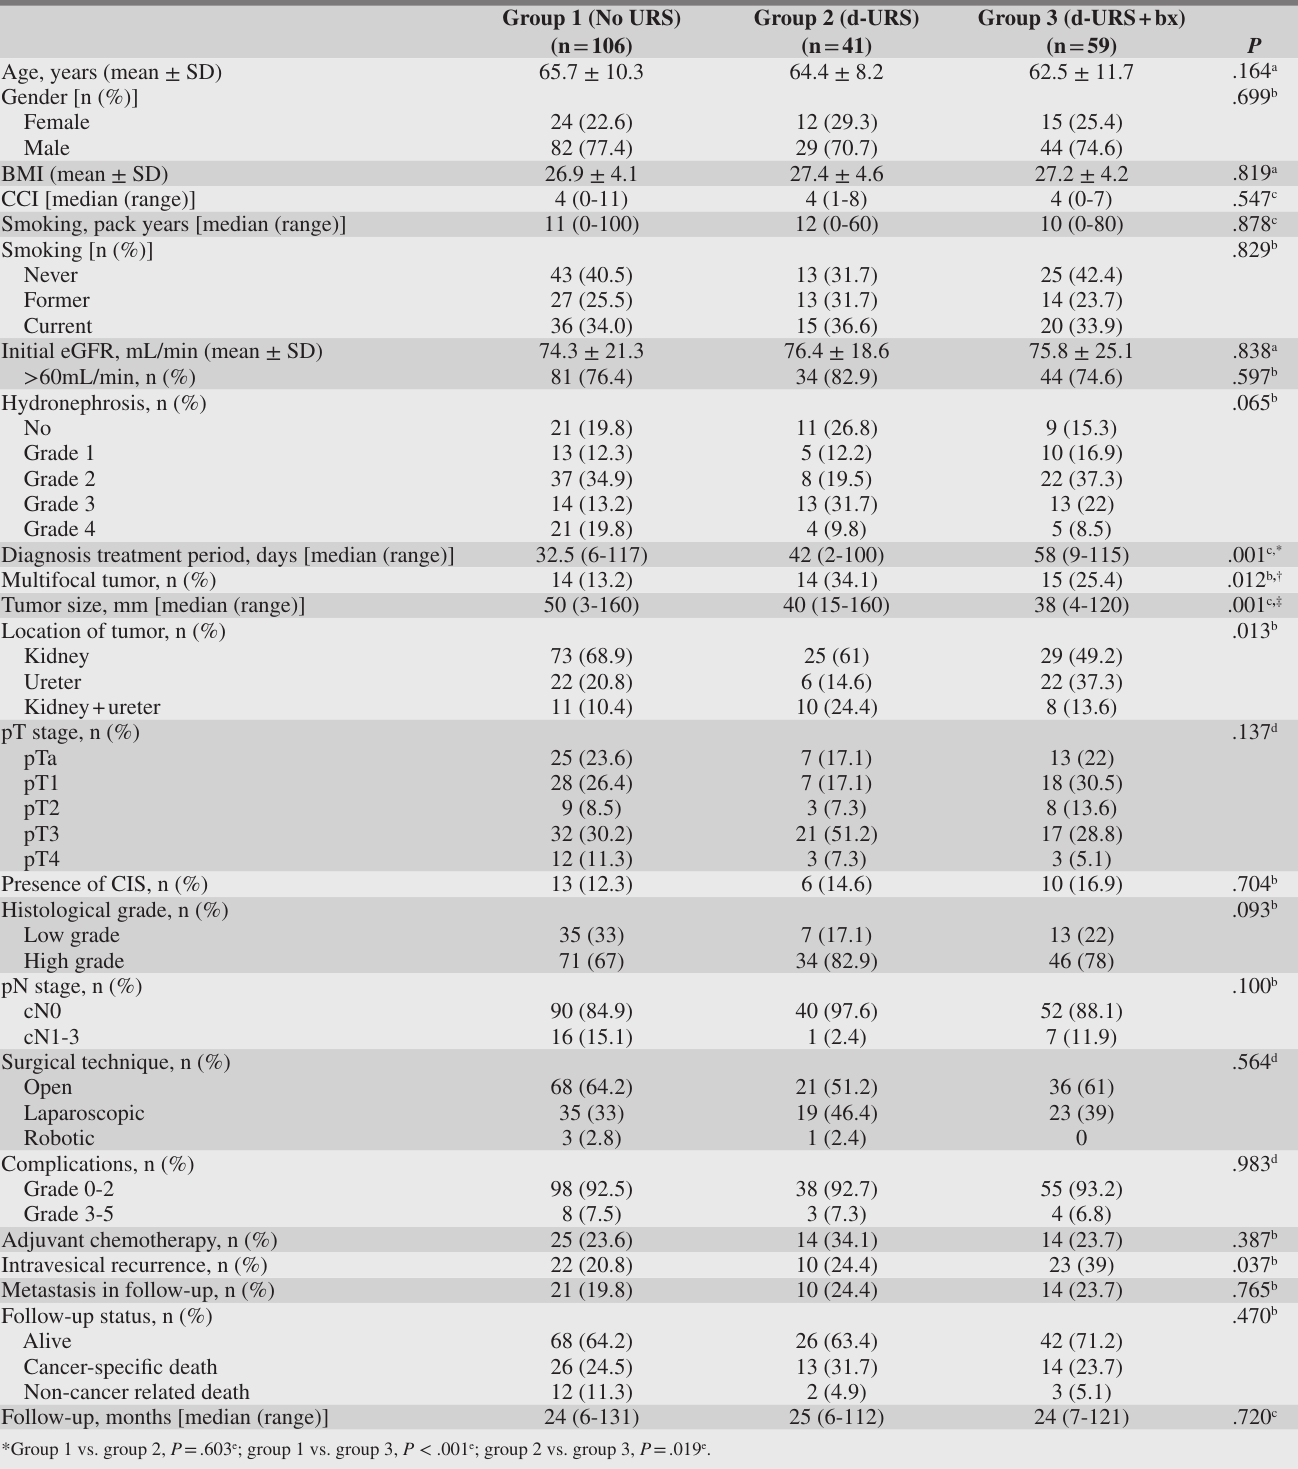
Table 1. Distributions of Diagnostic Characteristics According to